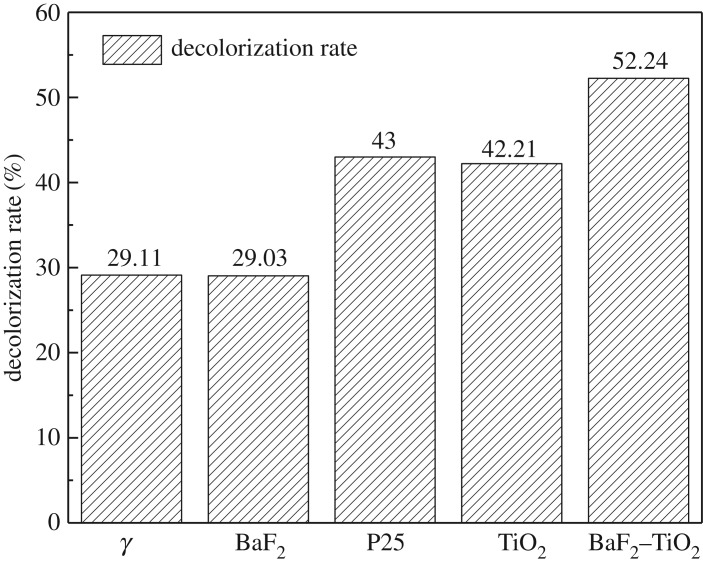
Effect of different catalysts on the decolorization rate of γ-ray irradiated methyl orange solutions (CBaF2, CTiO2, CP25: 1 g l−1; C0.75-BaF2–TiO2: 1.75 g l−1).